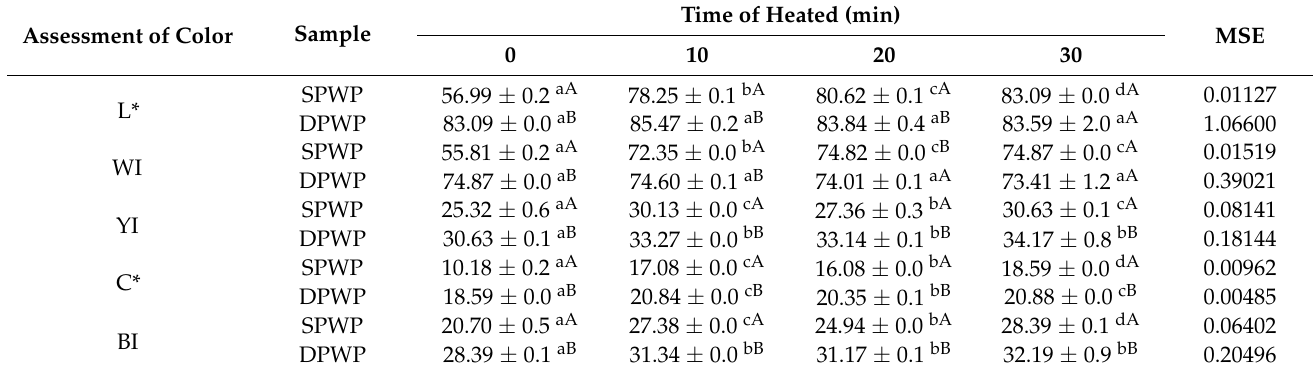
Table 2. Assessment of color polymerized whey protein depending on the heating